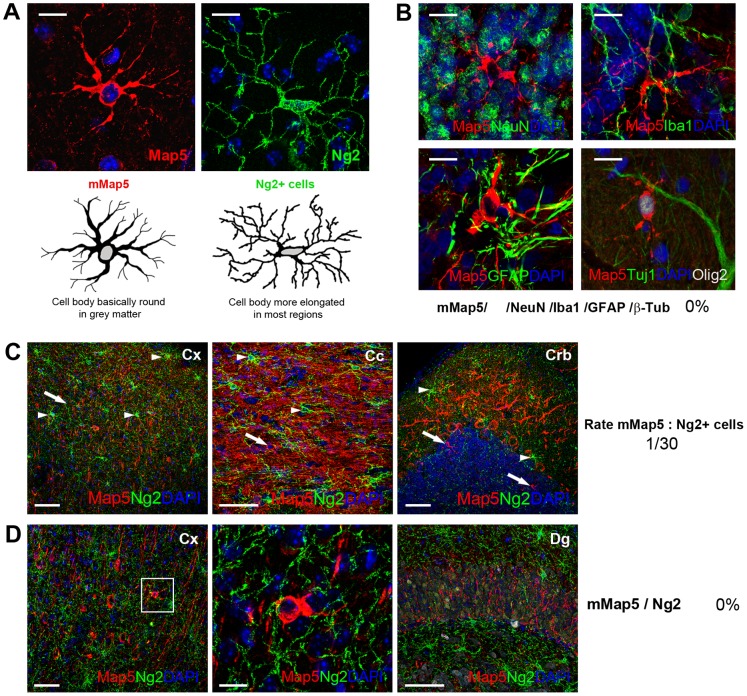
Morphological and phenotypic characterization of mMap5 cell population.A, Despite a substantially similar appearance, mMap5 cells are slightly different from Ng2+cells as to the shape of their cell body (quantifications of cell soma diameters is showed in Fig. S2A). The photographs are representative of two extremes: round-shaped and elongated cell bodies. B, Double staining with neuronal and glial antigens indicate that mMap5 cells are not neurons nor astrocytes or microglia. C, mMap5 cells (arrows) are ramified elements with a morphological appearance similar to Ng2+cells (arrowheads) but far less numerous. D, mMap5 cells and Ng2+cells belong to two distinct, non overlapping populations. Crb, cerebellum; Cx, cerebral cortex; Cc, corpus callosum; Dg, dentate gyrus of the hippocampus. Scale bars: A,B, 10 µm; C,D, 50 µm; inset in D, 10 µm.